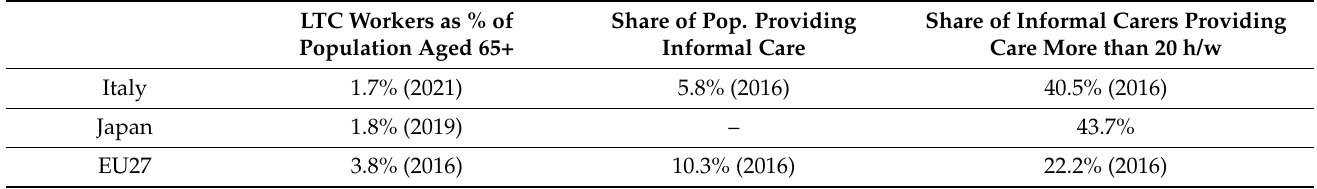
Table 4. LTC workers and caregivers.